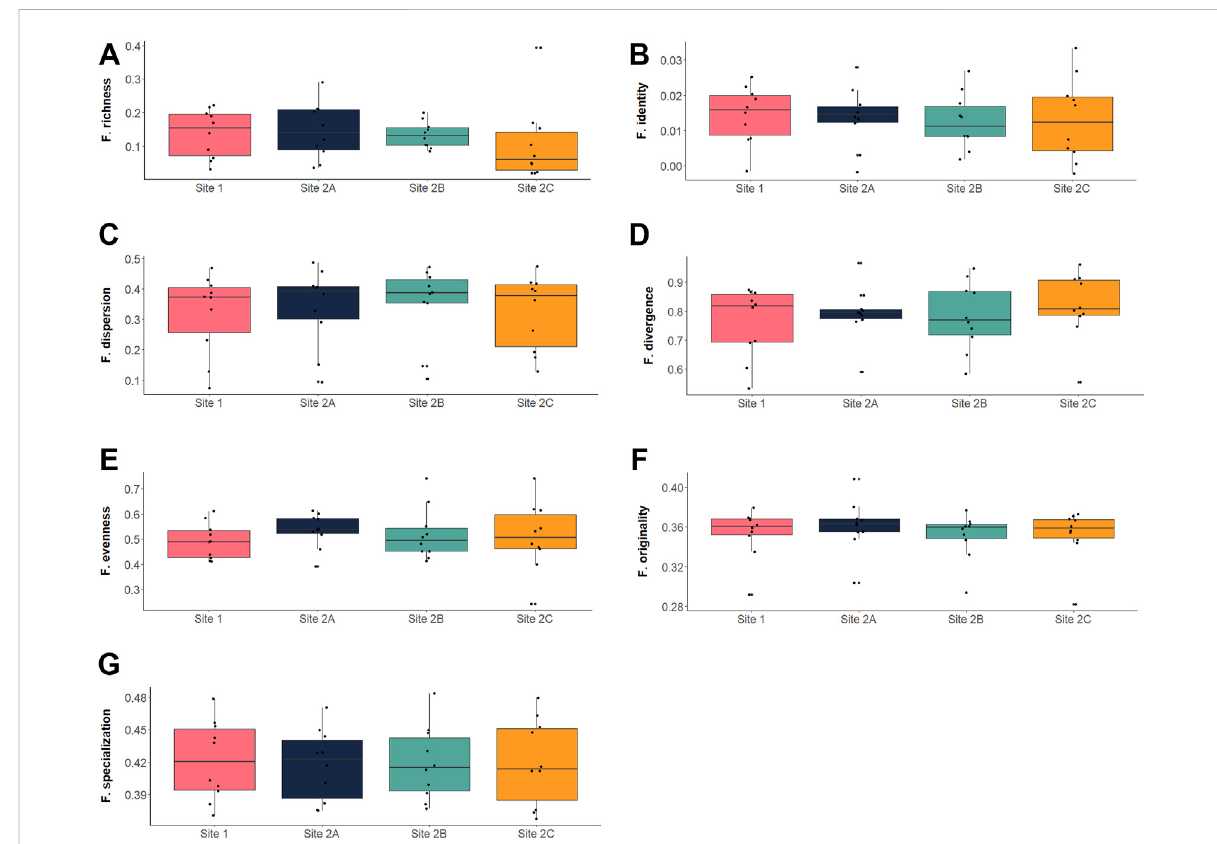
FIGURE 4 Boxplots representing the functional diversity values for the calculated indices: (A) functional richness (Villéger et al., 2008); (B) functional identity (Mouillot et al., 2013); (C) functional dispersion (Laliberté & Legendre, 2010); (D) functional divergence (Villéger et al., 2008); (E) functional evenness (Villéger et al., 2008); (F) functional originality (Mouillot et al., 2013); (G) functional specialization (Mouillot et al., 2013). Each black dot represents an observed value at each of the 10 sampling occasions (10 dots per site per index).